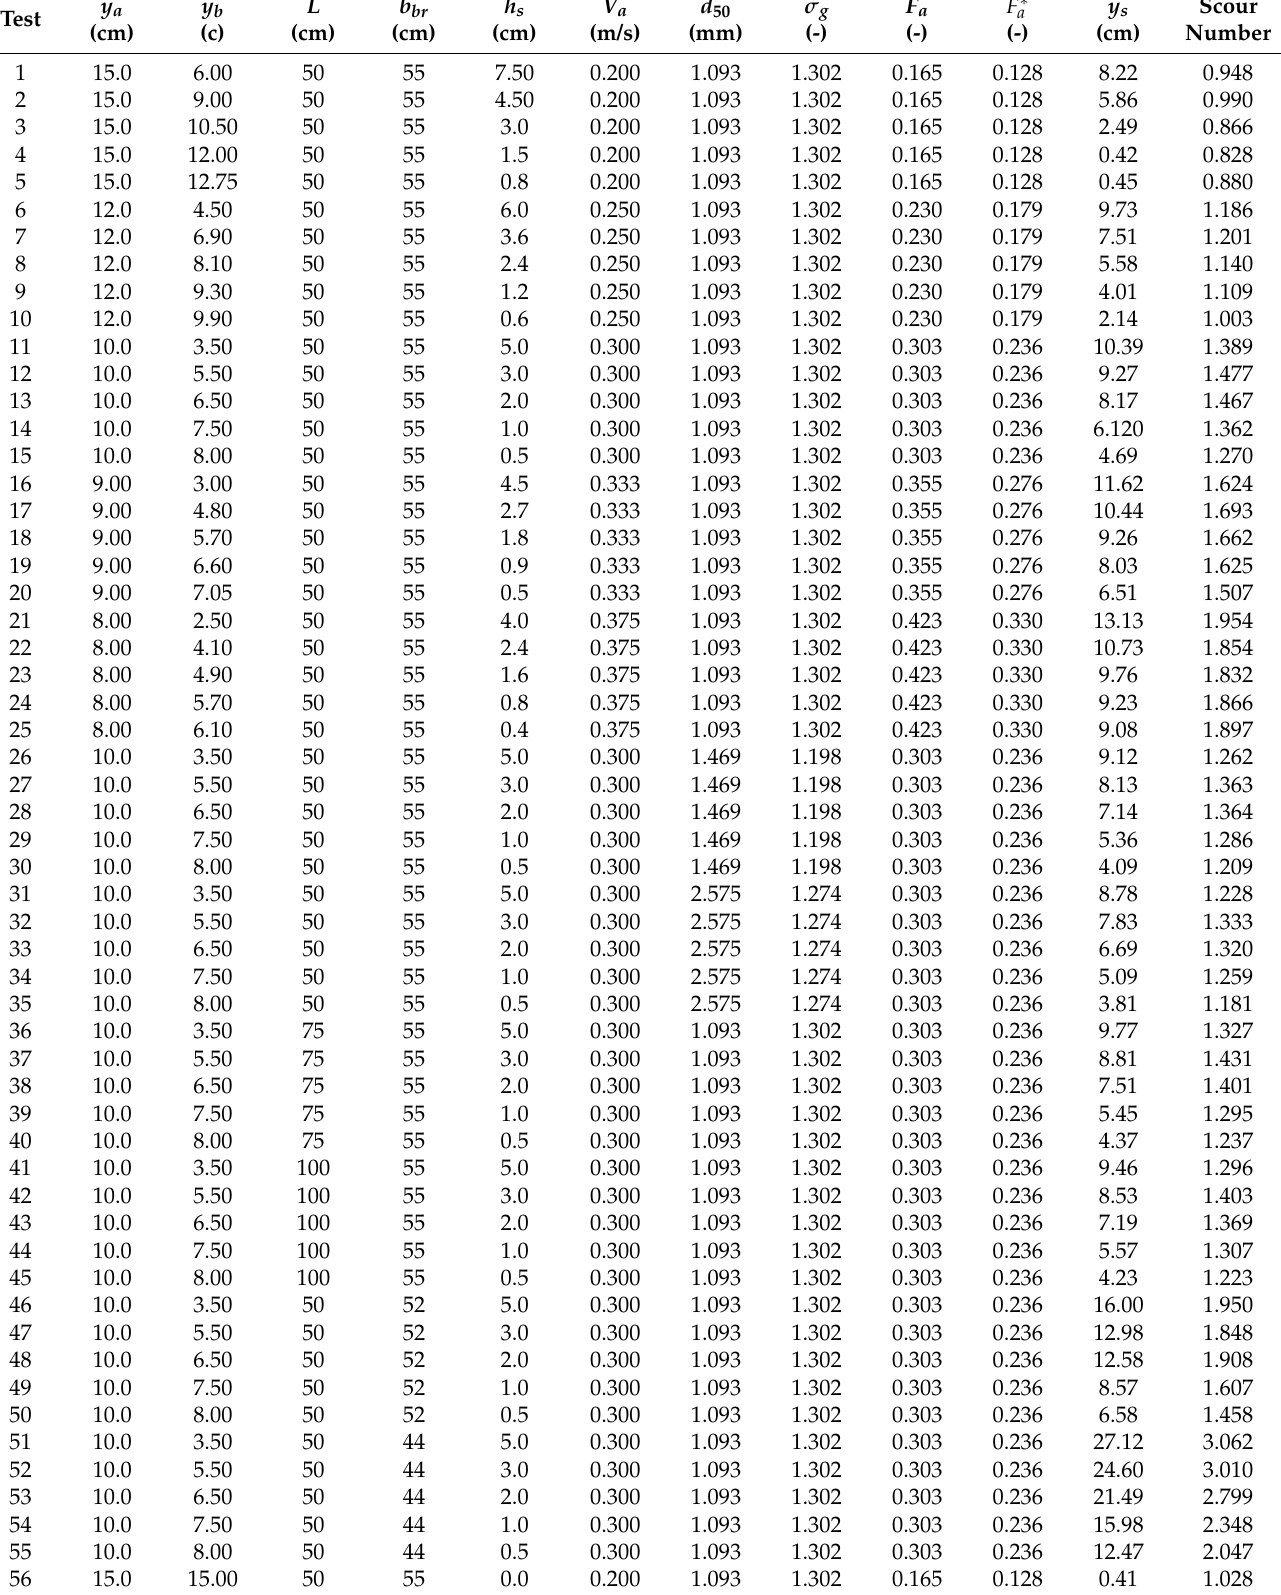
Table 3. Laboratory data and computed scour